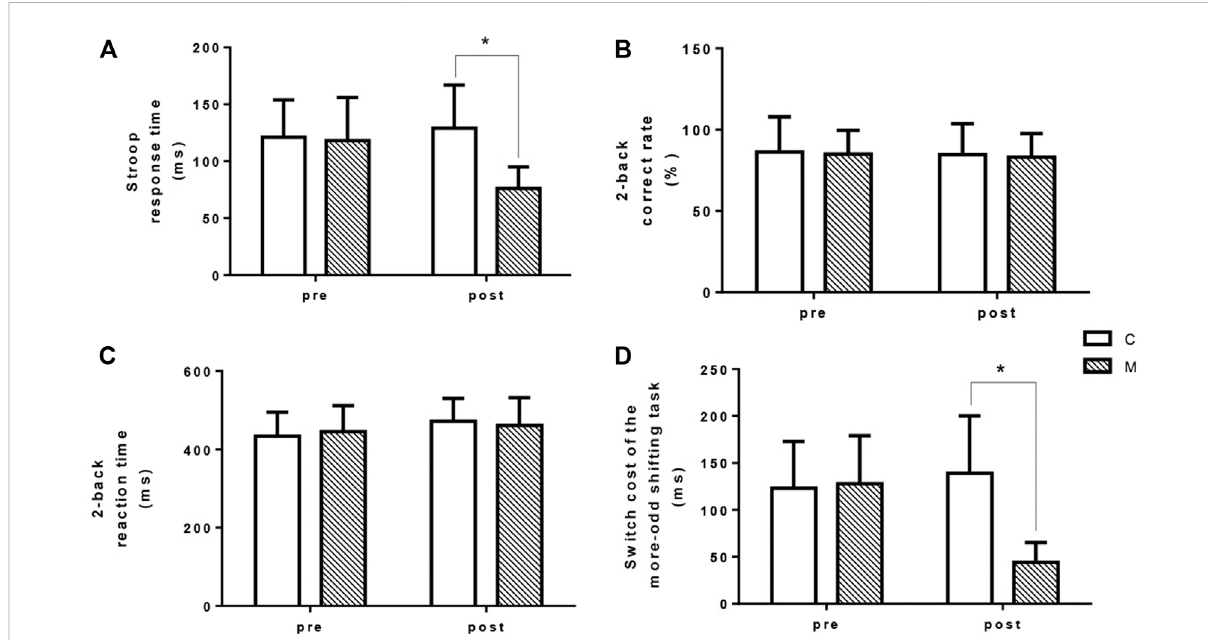
FIGURE 6 Changes in Stroop response time (A) , 2-back correct rate (B) , 2-back reaction time (C) , and switch cost of the more-odd shifting task (D) pre- and post-simulated tennis match in both CON and MCOOL conditions. *Indicates p < 0.05 between groups. All values are presented as Mean ± SD. M, mixed-cooling condition; C, control